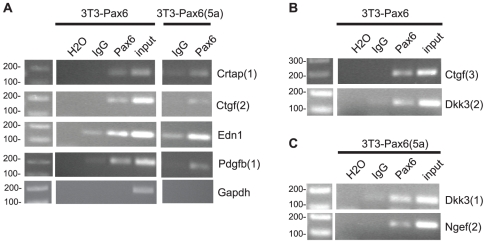
Chromatin immunoprecipitation verifies binding of Pax6 and Pax6(5a) to the promoter region of several target genes.Chromatin immunoprecipitation with an antibody against Pax6 was done for both the 3T3-Pax6 and the 3T3-Pax6(5a) cell line. IgG was used as a control. PCR primers were designed so that they should amplify target sequences with putative Pax6 and/or Pax6(5a) binding sites in the promoter regions of Crtap, Ctgf, Edn1, Pdgf, Dkk3 and Ngef. The number in parenthesis specifies the identity of the primerset used for the observed amplification. Genomic DNA sampled before adding the antibody (input) was used as a positive control for the PCR reaction, while water was used as a negative control. The promoter region of Gapdh was included as a region not expected to bind Pax6 or Pax6(5a).